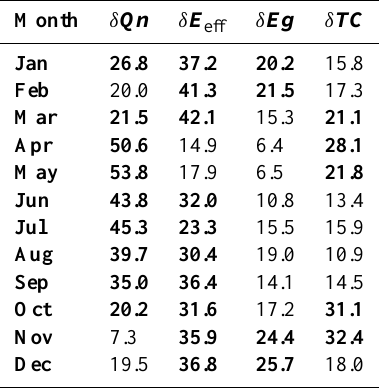
2 calculated by (3) for January 2